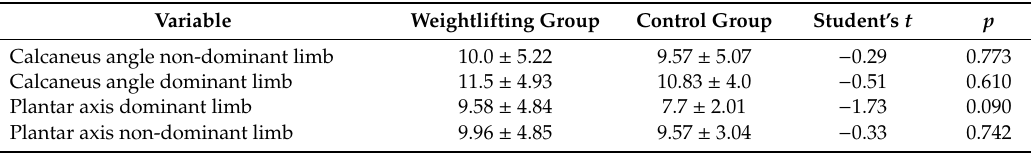
Table 5. Dynamic calcaneus angle and plantar axis of the dominant and non-dominant limb and between-group comparisons (Student’s t and p value).